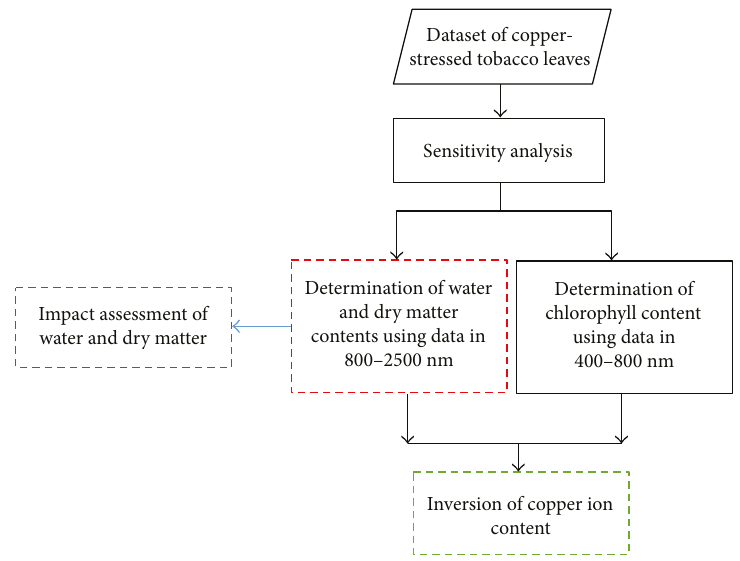
Figure 1: Diagram of copper ion content